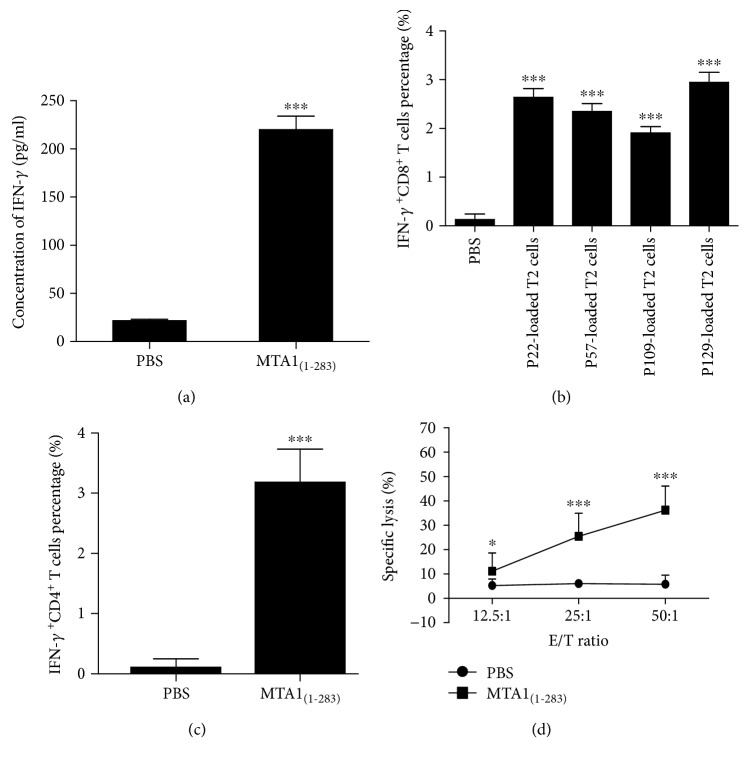
Specific lysis of various cell lines and IFN-γ secretion by induced T cells in HLA-A2.1/Kb transgenic mice immunized with MTA1(1–283). MTA1(1–283) (100 μg/ml) or the same volume of PBS (negative control) emulsified in IFA was used to immunize HLA-A2.1/Kb transgenic mice on days 0 and 7. On day 14, the mice were sacrificed, and their splenocytes were collected and restimulated for another 6 days with the peptide pool (10 μg/ml) and 50 U/ml rmIL-2 in vitro. (a) Serum was collected from the immunized mice on day 14, and the serum IFN-γ concentration was measured by ELISA. (b) The percentage of IFN-γ secreting peptide-specific CD8+ T cells induced by MTA1(1–283) and PBS was analyzed by an intracellular staining assay. (c) The percentages of IFN-γ+CD4+ T cells in the MTA1(1–283) and PBS groups were determined. (d) Specific lysis of target cells SW620 cells (HLA-A2+, MTA1+) was assessed by the LDH cytotoxicity assay. ∗
P < 0.05 and ∗∗∗
P < 0.001. P < 0.05 vs. the control group. Data represent means ± SD (n = 5).